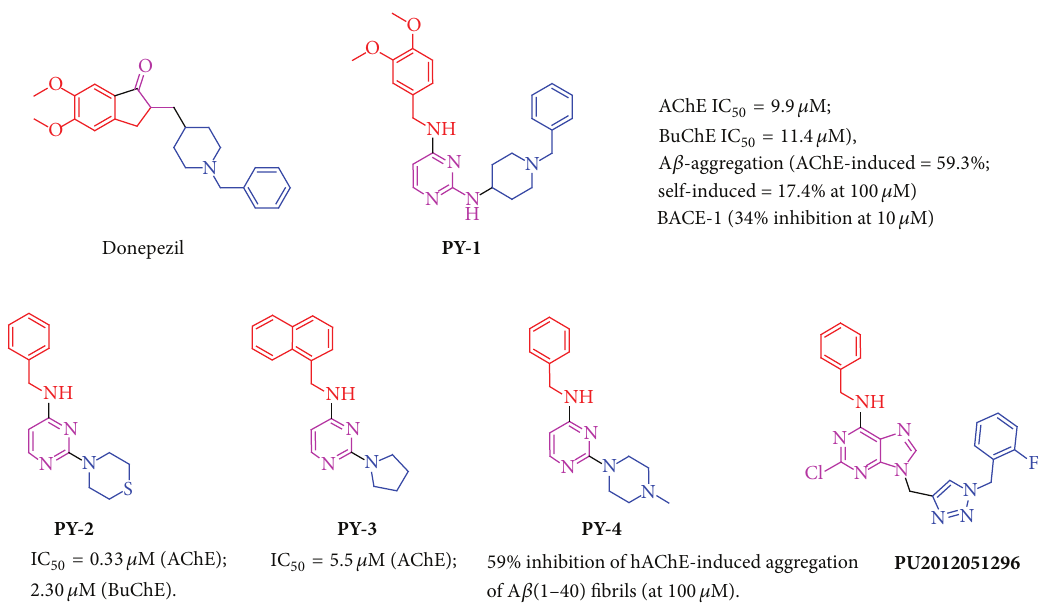
Figure 1: Structure of donepezil, 2,4-disubstituted pyrimidine AChE inhibitors, and purine derivative PU2012051296 .